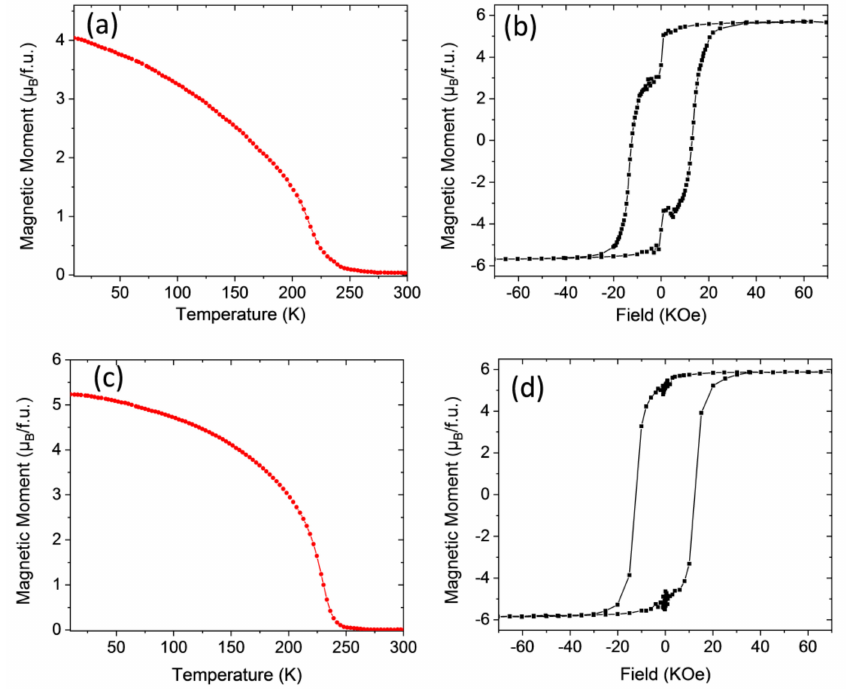
Figure 4. ( a ) Magnetization vs. temperature of the LCMO / LAO–1 film thermally treated in RTA conditions, measured after field cooling with a magnetic field of 1 kOe applied parallel to (100)-LAO, (in-plane). ( b ) M–H loop of the same sample recorded at 10 K by applying the magnetic field H in-plane. ( c ) Temperature dependence of the magnetization under an in-plane applied magnetic field of 1 kOe, of sample LCMO / LAO–1R. ( d ) M–H loop of sample LCMO / LAO–1R recorded at 10 K by applying the magnetic field H